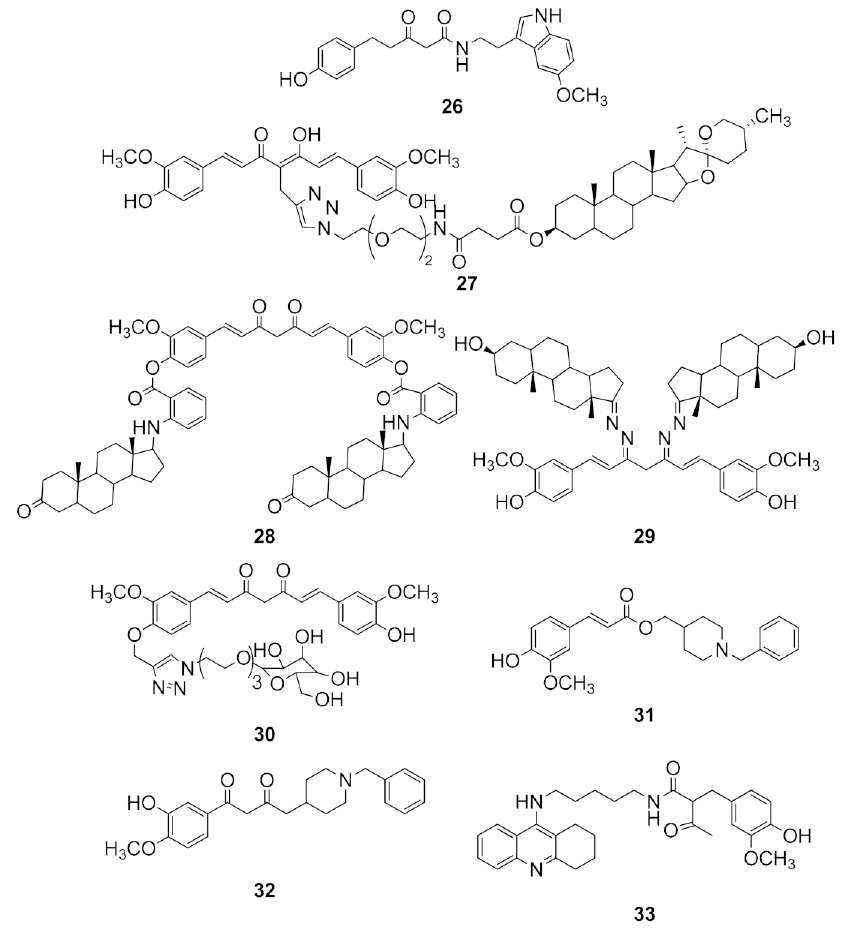
Figure 11. Curcumin hybrid